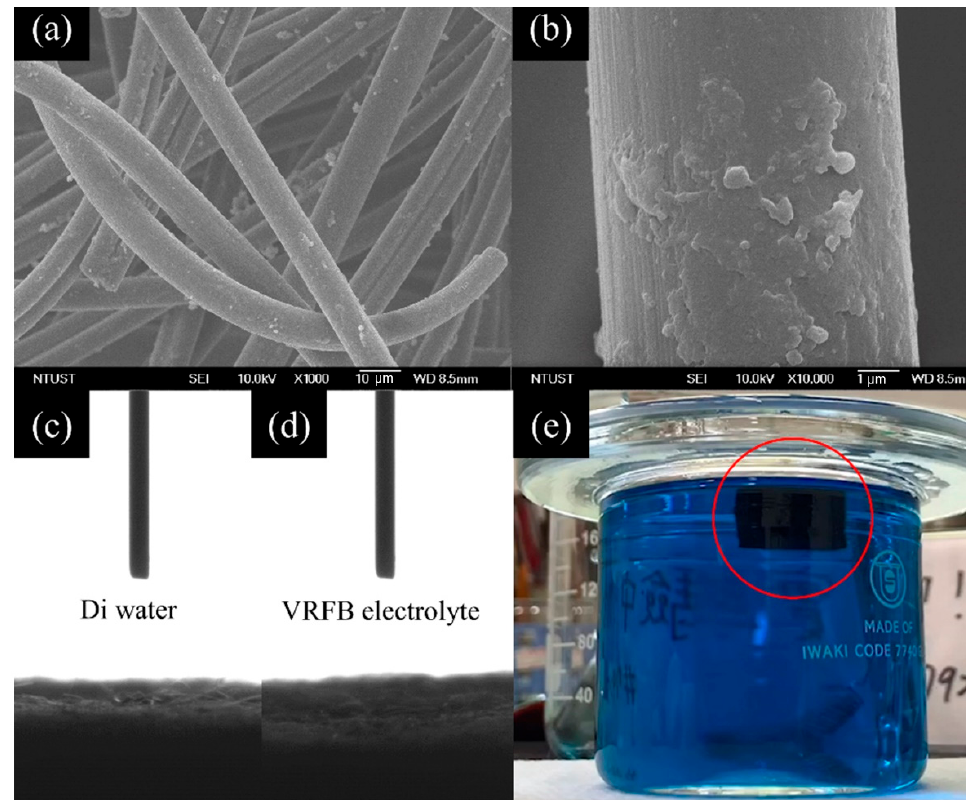
Figure 4. SEM images of APPJ-coated polydopamine on GF ( a ) ×1000 ( b ) ×10,000, and the contact angle measurements of pristine GF using ( c ) deionized water ( d ) VRFB electrolyte solution, and ( e ) a sinking test in VRFB electrolyte solution.